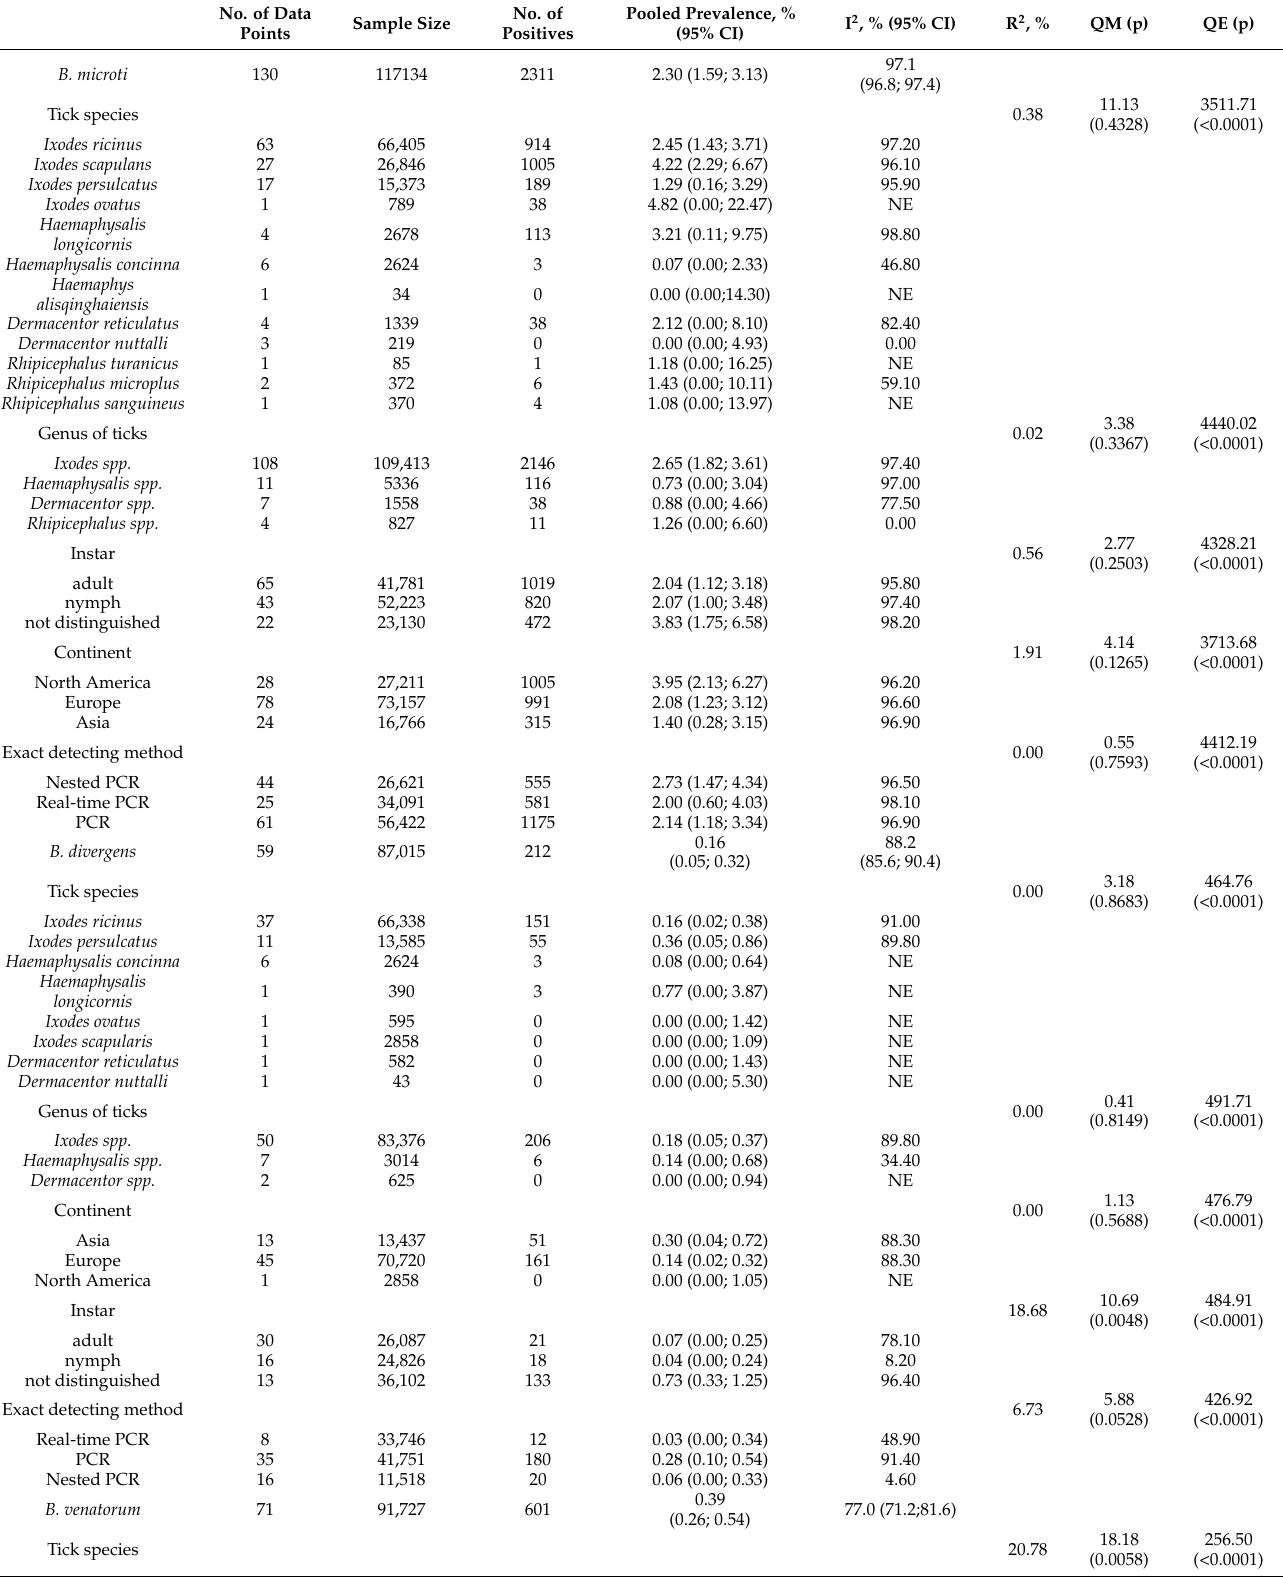
Table 3. Estimates of pooled nucleic acid prevalence and subgroup analysis of zoonotic Babesia in questing